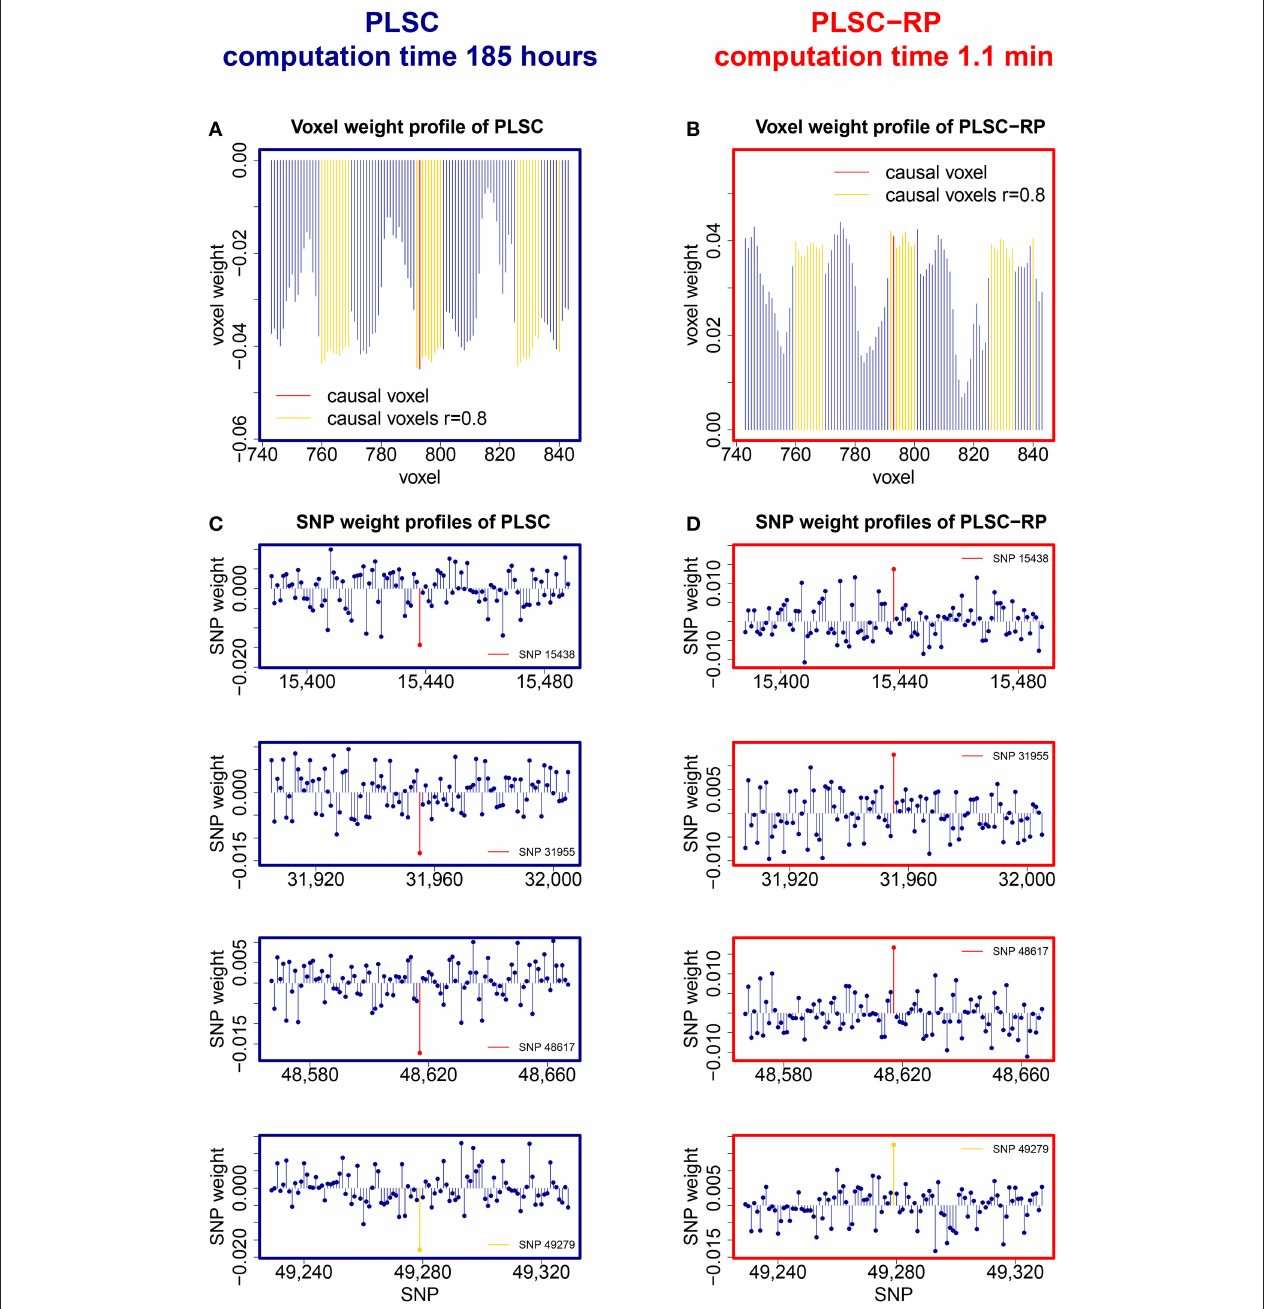
FIGURE 4 | PLSC and PLSC-RP weights for high-dimensional neuroimaging and high-dimensional SNP data. (A) Voxel weight profile and (C) SNP weight profiles of the causal PLSC component for 1000 simulated voxels and 50,000 simulated SNPs. (B) Voxel weight profile and (D) SNP weight profiles of the causal PLSC-RP component after dimensionality reduction of both data sets to 100 dimensions. The causal voxel and causal SNPs (red), and voxels in collinearity with the causal voxel (yellow), receive higher weights than non-causal voxels and SNPs (blue). In addition to the causal SNPs, several other SNPs were found to be highly weighted, such as SNP 49,279 (bottom row, highlighted in yellow). For visualization purpose, the voxel weight profiles (A,B) and the SNP weight profiles (C,D) are zoomed in on a range representing causal variants.